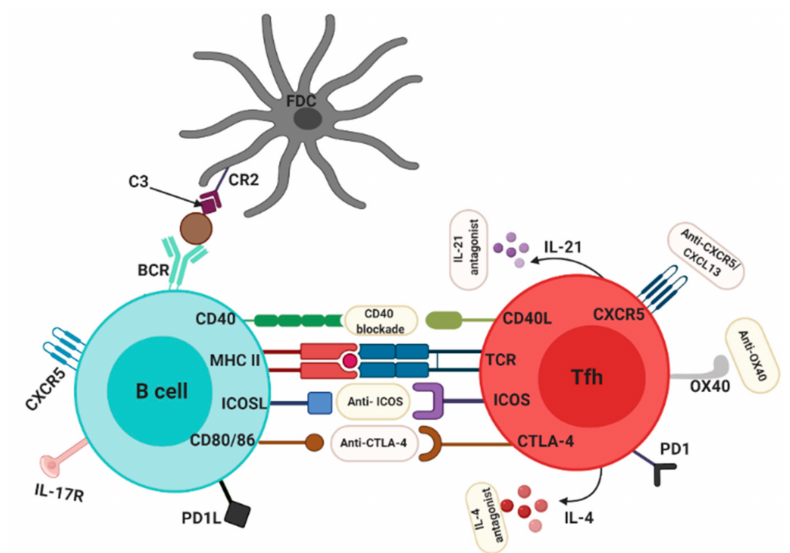
Figure 2. Possible therapeutic targets on Tfh cells for the treatment of RA. Several molecules and receptors expressed on Tfh can be targeted to dampen aberrant immune responses in RA such as anti-ICOS, anti-CTLA4, anti-OX40, anti-CXCR5, Anti-CD40, IL-21 antagonist and IL-4 antagonist. CR2, complement receptor 2; FDC, follicular dendritic